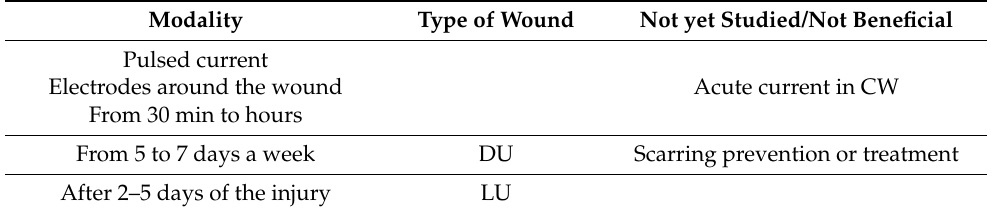
Table 9. Summary of the practical initial application of electrical stimulation (ES) in wound healing (WH). Modality Type of Wound Not yet Studied/Not Beneficial Pulsed current